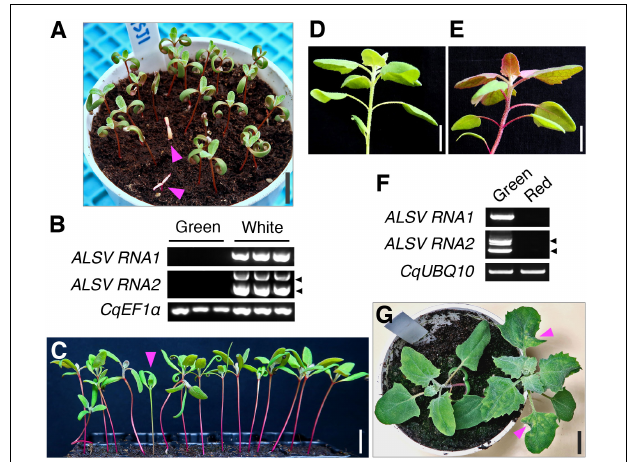
FIGURE 5 | ALSV VIGS can be transmitted to progeny plants through seeds at a low frequency. (A) A representative image of progeny seedlings with the photobleaching phenotype at 7 dpg, derived from plants inoculated with ALSV-CqPDSC in the inbred Iw line. Arrowheads indicate progeny seedlings with the photobleaching phenotype. (B) Semi-quantitative RT-PCR of ALSV RNA1 and RNA2 in the progeny seedlings with (white) or without (green) the photobleaching phenotype shown in (A) . CqEF1 α was used as an internal control. Arrowheads indicate the positions of recombinant ALSV RNA2 with the trigger sequence (top) and WT RNA2 without the trigger sequence (bottom). (C) An arrowhead indicates a progeny seedling that has not accumulated betalain in the hypocotyl at 14 dpg, derived from J056 inbred line plants inoculated with ALSV-CqDODA1. (D,E) Representative images of a plant with a green hypocotyl (D) or red hypocotyl (E) at 4 wpg, derived from J056 inbred line plants inoculated with ALSV-CqDODA1. (F) Semi-quantitative RT-PCR of ALSV RNA1 and RNA2 in progeny seedlings with a green or red hypocotyl shown in (D,E) . CqUBQ10 was used as an internal control. Arrowheads indicate positions of recombinant ALSV RNA2 with the trigger sequence (top) and WT RNA2 without the trigger sequence (bottom). (G) A representative image of a progeny plant with chlorotic spots in leaves at 20 dpg, derived from the Iw inbred line plants inoculated with ALSV-WT. Arrowheads point to chlorotic spots in leaves in progeny seedlings with ALSV-WT. Scale bars represent 1